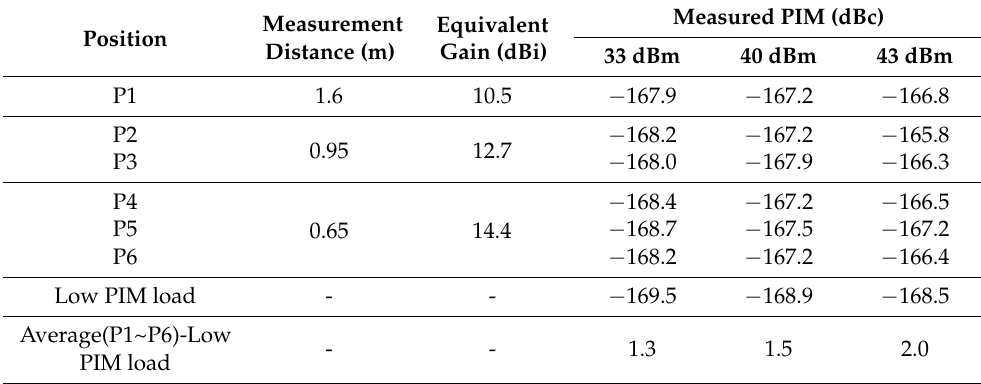
Figure 9. Measurement positions in PIM measurement chamber B. Table 3. Measured results of chamber B at 900 MHz.